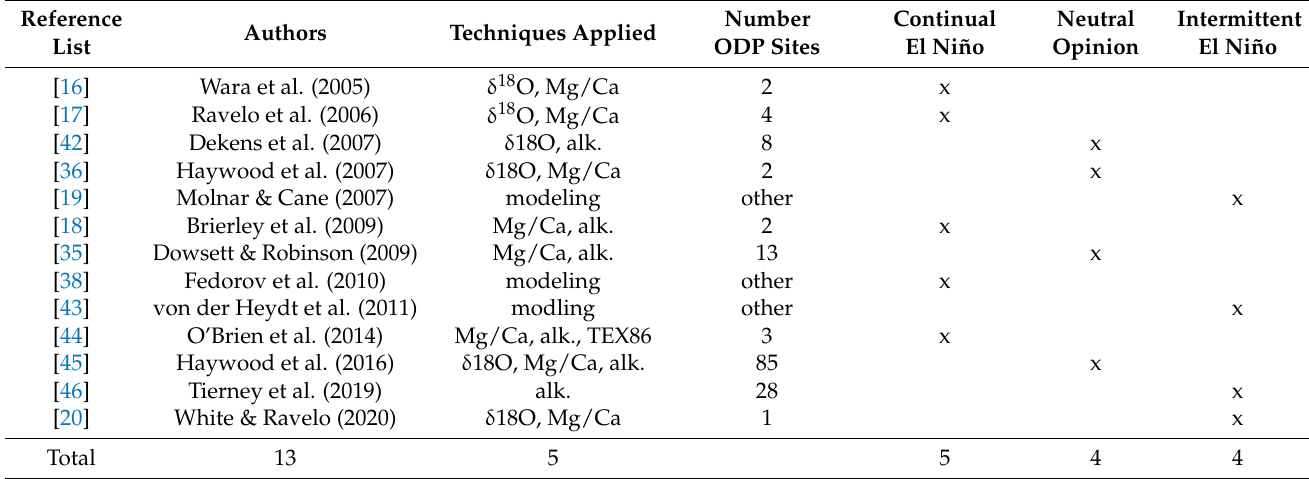
Table 1. Opinions on the Pliocene Warm Period and its severity as a precursor to future El Niño conditions. The abbreviation “alk” is for alkernones based on the U k (cid:48) /37 index. ODP refers to Ocean Drilling Program sites. A neutral opinion registered in this summary signifies a call for additional